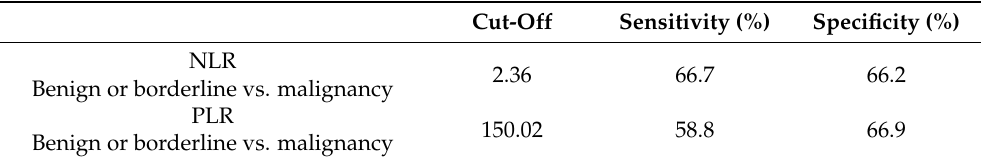
Table 3. Appropriate cut-off value, sensitivity and specificity for differentiating benign/borderline and malignant ovarian tumor using ROC curve analysis. Cut-Off Sensitivity (%) Specificity (%)